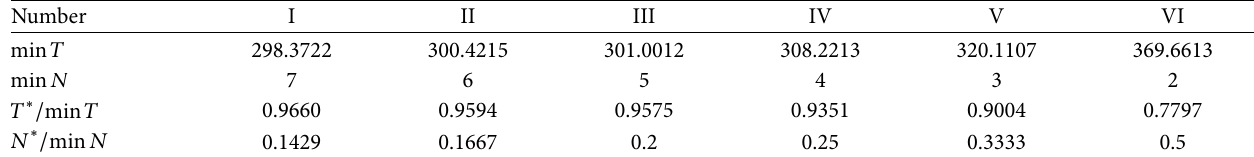
Table 10: The transshipment efficiency (